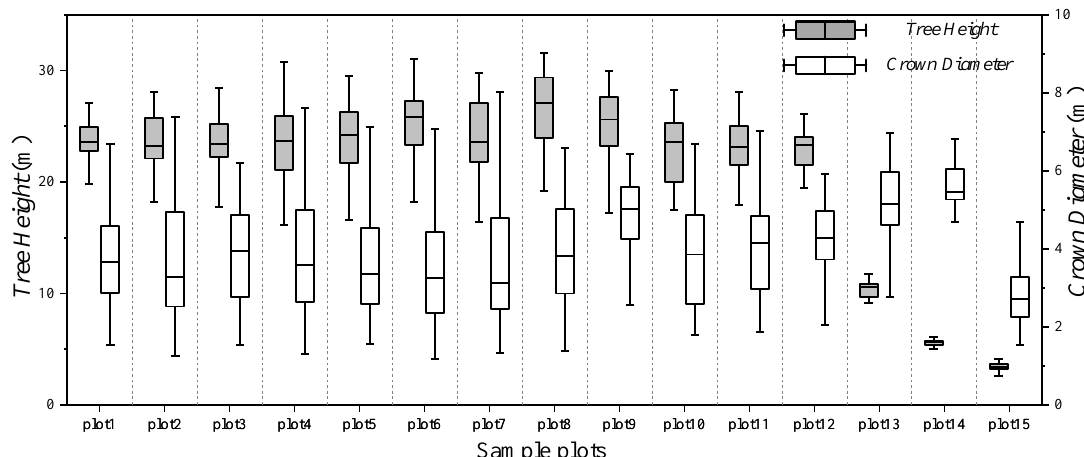
Figure 10. Boxplot of tree height and crown diameter of 15 sample plots.